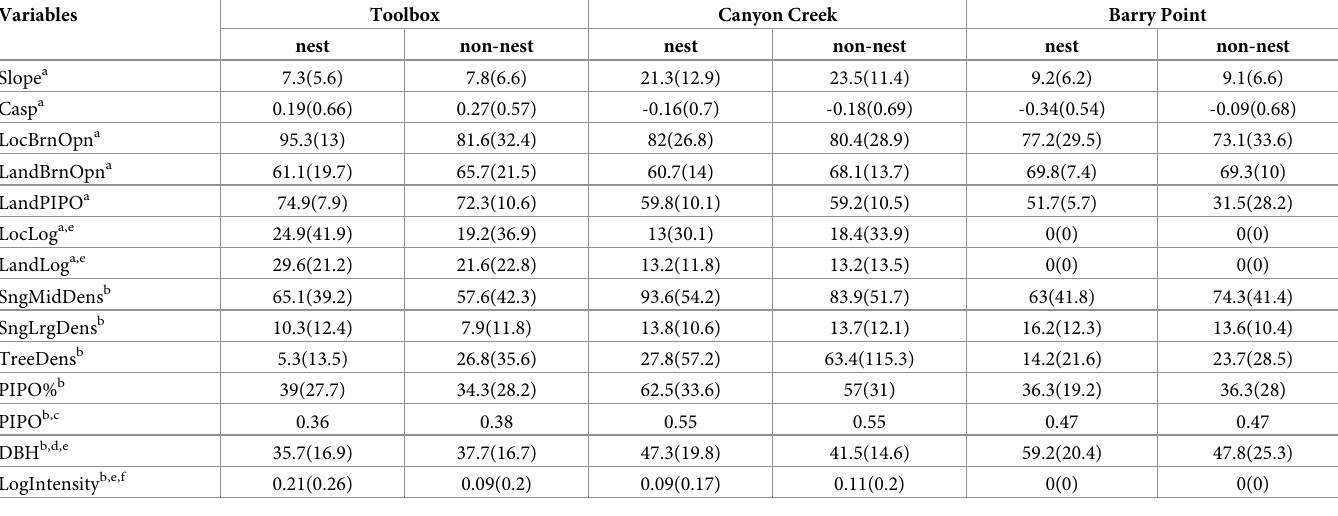
Table 3. Mean (SD) values for remotely sensed and field-collected variables for nest and non-nest sites at three wildfire study locations. Complete variable names and descriptions are in Table 2. n = 33 and 134 for Toolbox nests and non-nests, n = 47 and 176 for Canyon Creek nests and non-nests, and n = 19 and 19 for Barry Point nests and non-nests, respectively. Units are % for Slope, number per ha for tree and snag densities (SngMidDens, SngLrgDens, TreeDens), and cm for DBH.